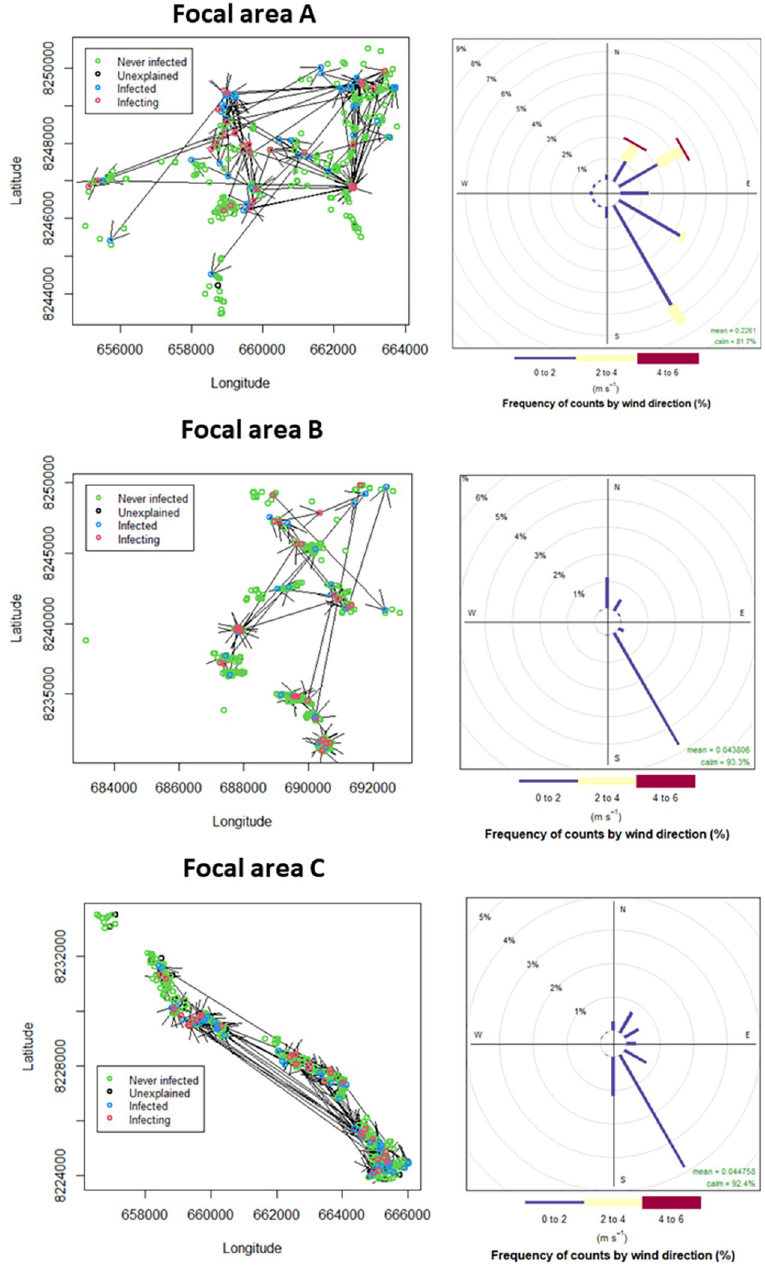
Fig 5. Successful mosquito connections (left panels) are shown as arrows departing from an infecting house (red circle) and arriving to an uninfected (and subsequently infected) house (blue circle). Unexplained (black circle) are houses that are not analysed because they are outside the spatial and temporal scales considered by the best models. The wind rose panels on the right show the frequency of wind directions and angular sector. The line colours identify the average speed of the winds. Calm refers to winds below 0.5